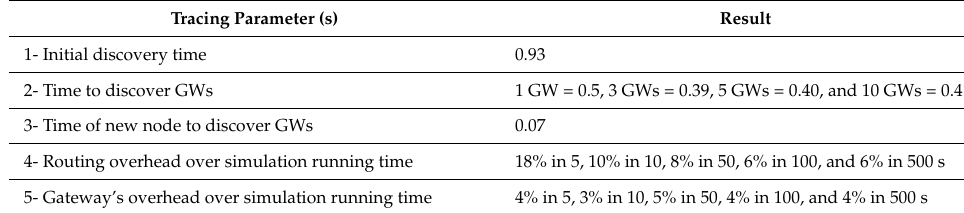
Table 8. Protocol tracing